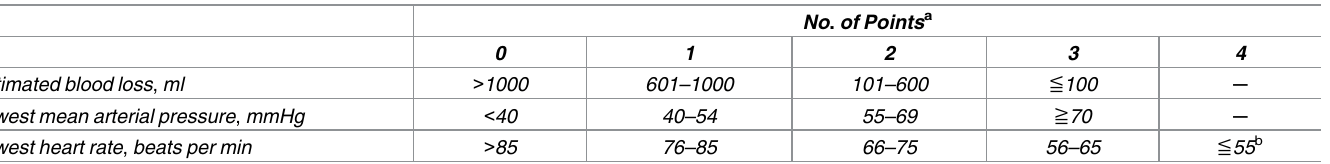
Table 1. The 10-Point Surgical Apgar